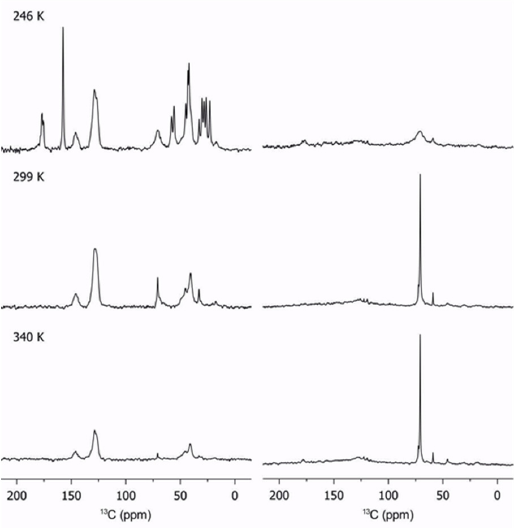
Figure 2. Evolution of cross ‐ polarization (left column) and direct ‐ pulse excitation (right column) of sample 3 with temperature. Note the decrease in intensity of the rigid segments as temperature is increased (left column).